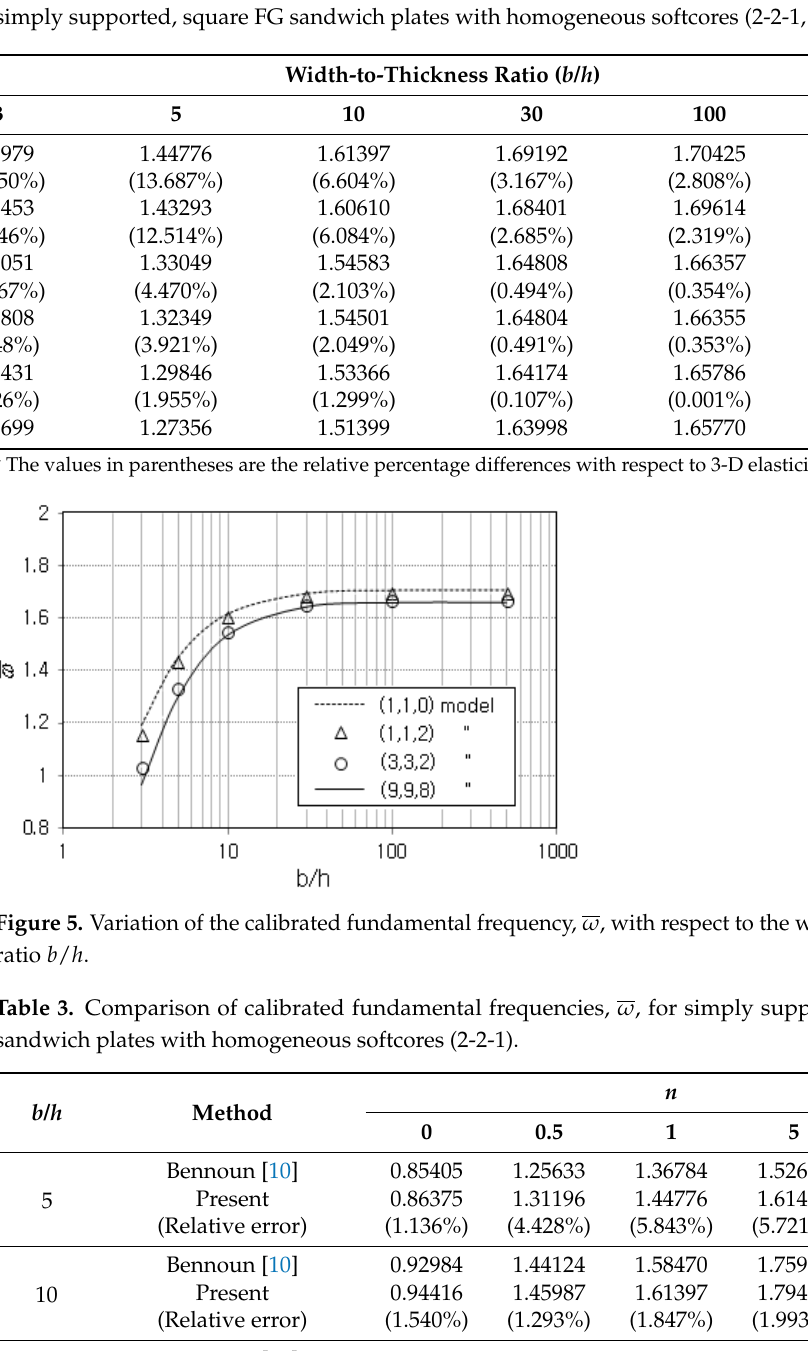
Table 2. The model limits of the calibrated fundamental frequencies, ω , of hierarchical models for simply supported, square FG sandwich plates with homogeneous softcores (2-2-1,